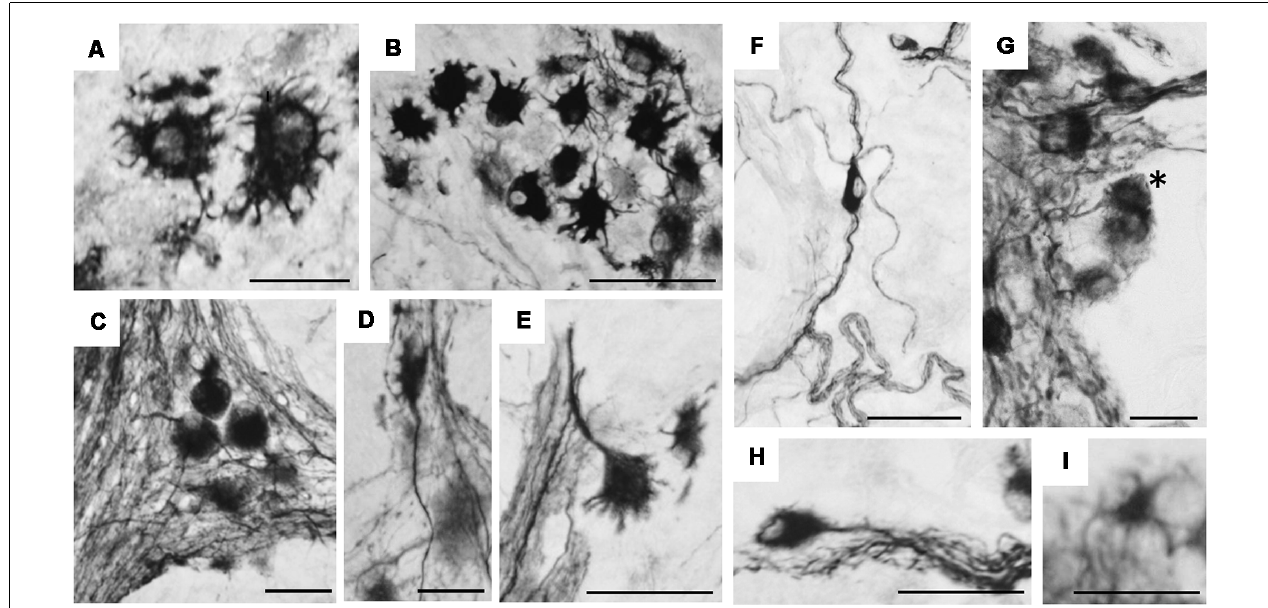
FIGURE 7 | Immunohistochemical staining using hpChAT antiserum in enteric ganglia of human ascending colon. Cell types of positive neurons were identified in myenteric plexus (A–E) and submucosal plexus (F–I) ; Dogiel type I bearing large (A) and small (B) cell bodies with short multiple dendrites, Dogiel type II having round or oval cell bodies with smooth surfaces and several prominent axonal processes (C) , Dogiel type III with protruding axon and short dendrites (D) , Dogiel type IV with single axon and short branching dendrites (E) , submucosal Dogiel type II (F) , Dogiel type IV [asterisk in (G) ], unipolar (H) and stellate cells (I) . Bars = 20 µ